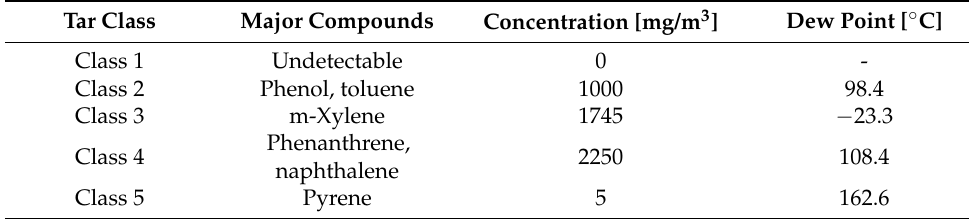
Table 4. Tar compound classification, tar-class concentrations, and corresponding dew point.